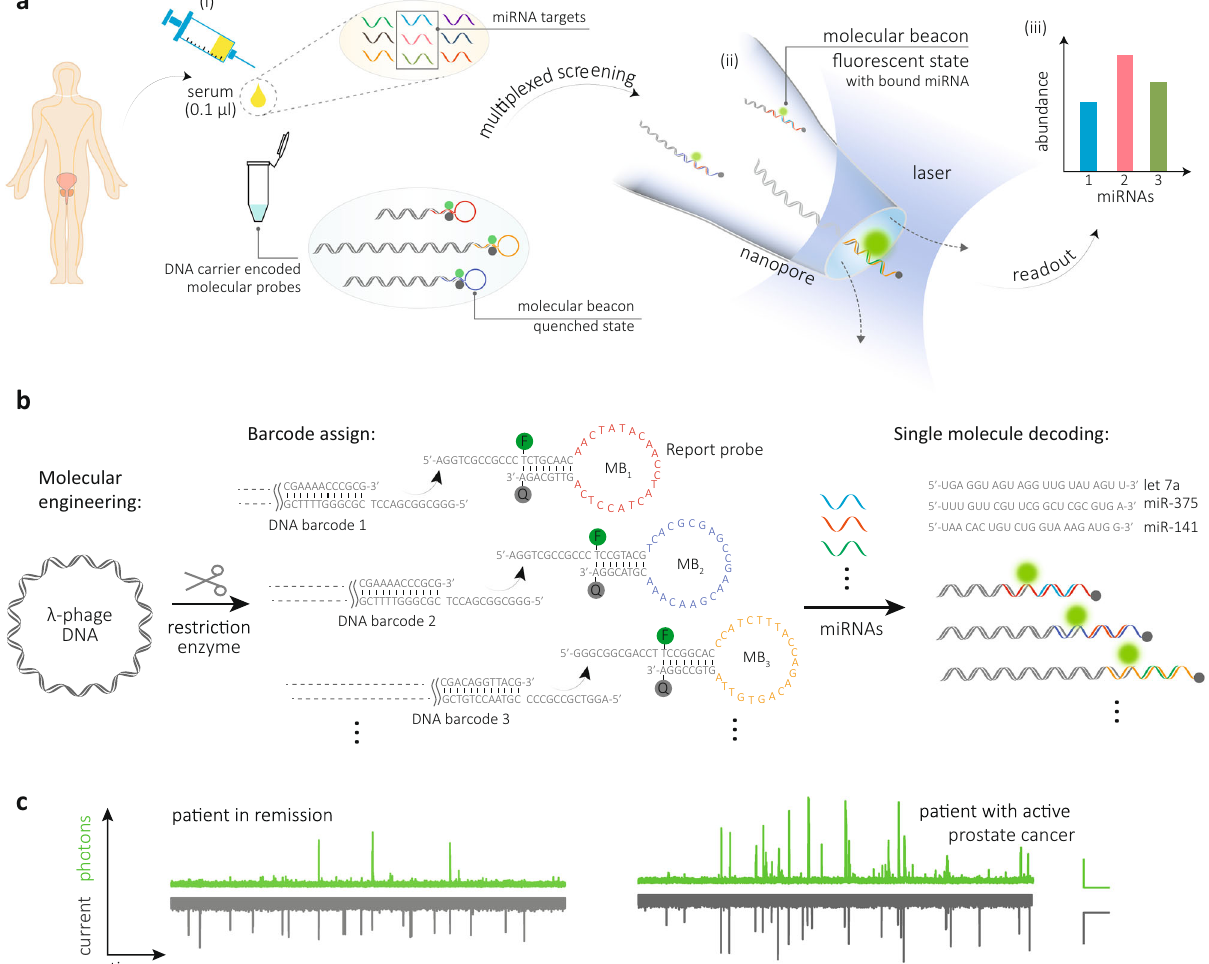
Fig. 1 Single-molecule multiplexed sensing using an electro-optical nanopore platform. a Work fl ow for detection of miRNAs directly from patient serum. (i) Serum from patients was incubated with length-encoded molecular probes consisting of a DNA carrier and molecular beacon (MB). (ii) Electro-optical sensing was then performed, and (iii) the miRNA expression levels were determined. b Schematic representation of the preparation of size-coded DNA probes and their binding to respective miRNA targets. Lambda-phage DNA is enzymatically engineered to generate different size fragments with 12-base single-stranded termini. Customised MB sequences are then assigned and hybridised to these fragments. Upon binding to the corresponding miRNAs, the ‘ stem-loop ’ structure unfolds, resulting in an increase in fl uorescence intensity induced by the increase in distance between the fl uorophore and the quencher. c Representative photon and current time traces for simultaneous detection of miR-141-3p and miR-375-3p from a patient in remission and a patient with active prostate cancer. Traces were recorded using asymmetric KCl buffer conditions (inside/outside nanopipette, 40/400 mM) at − 300 mV bias and a laser power of 90 ± 4 µ W. Scale bar of photon trace (green): vertical, 100 counts/ms, horizontal, 2.5 s. Scale bar of current trace: vertical, 30 pA, horizontal, 2.5